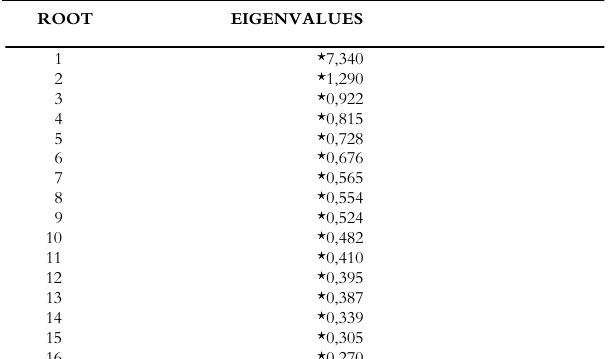
TABLE 5 ROTATED FACTOR MATRIX (DIRECTOBLIMIN ROTATION)